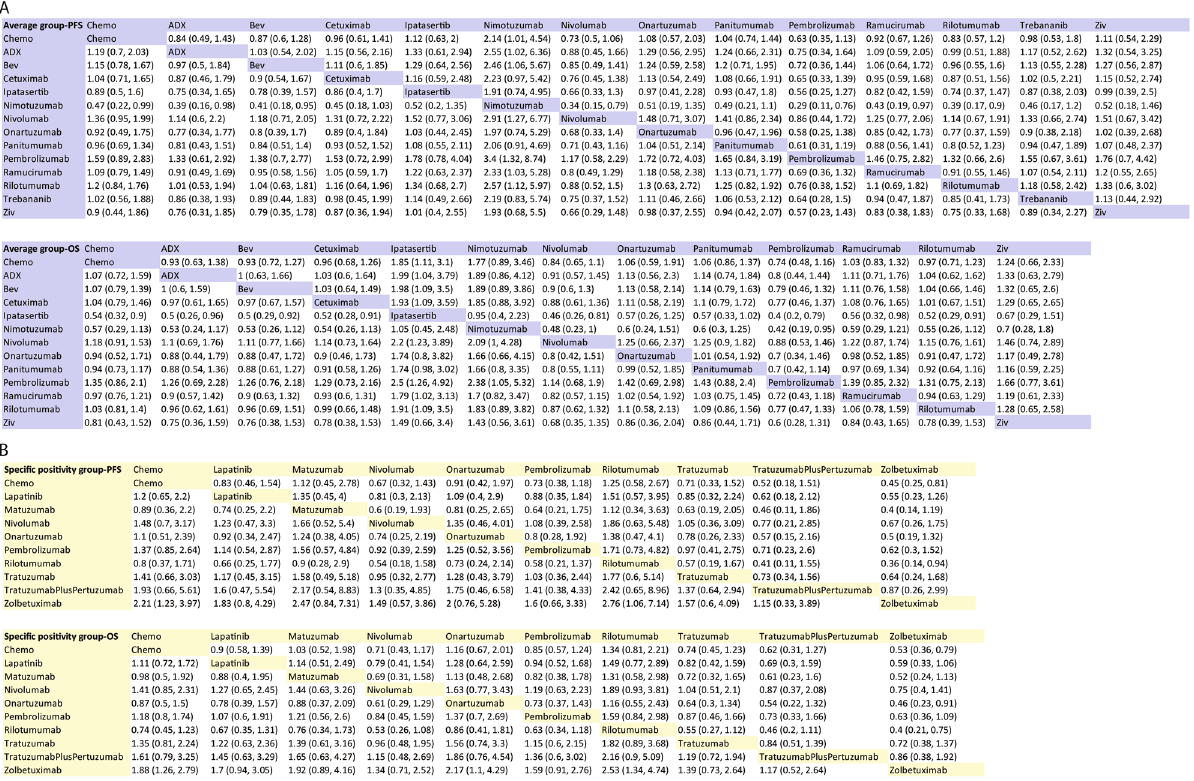
Figure 4. Network league table for secondary outcomes. ( A ) League table for PFS and OS in average group; ( B ) League table for PFS and OS in specific positivity